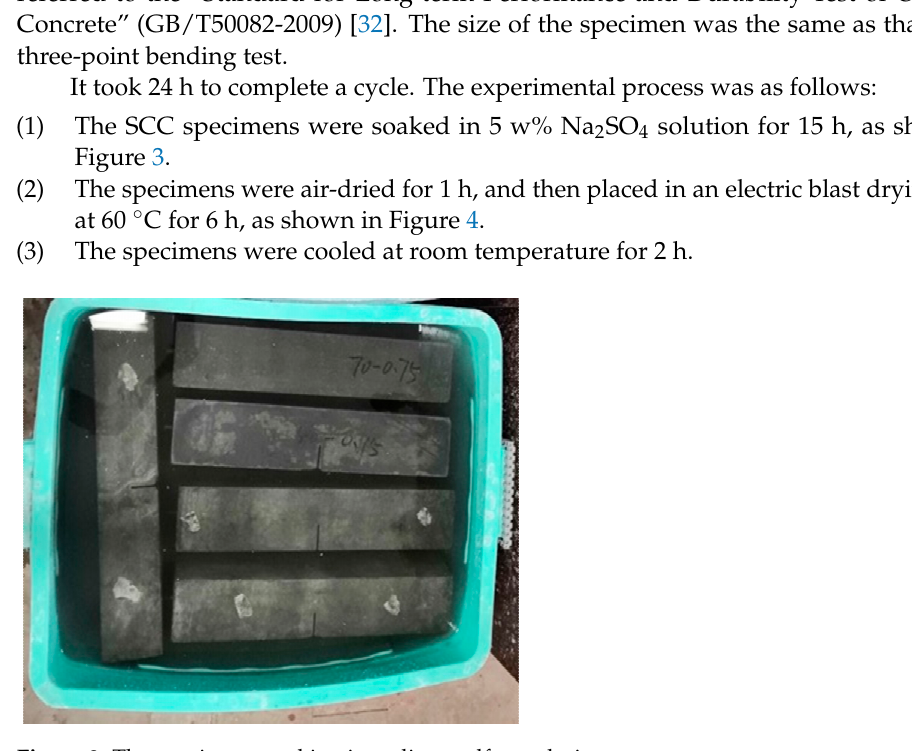
Figure 3. The specimens soaking in sodium sulfate solution.